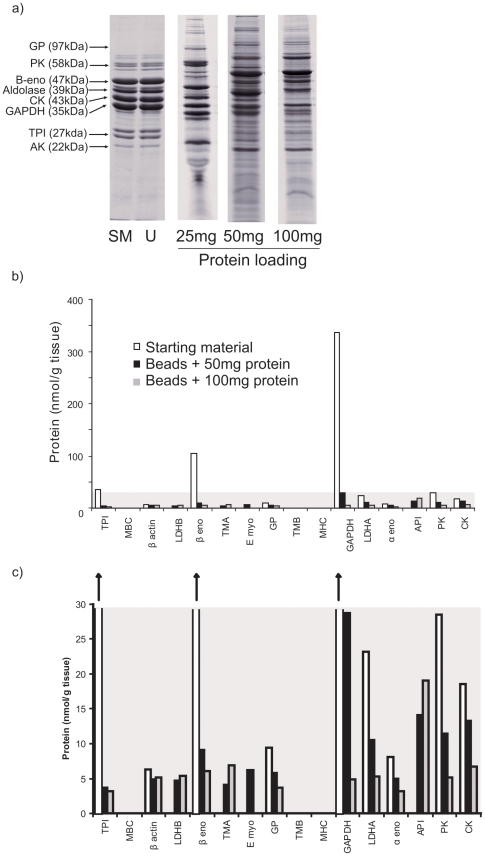
Equalization of skeletal muscle proteins by Prospectrum II equalization.a) Prospectrum II beads (20 mg) were exposed to increasing amounts of soluble protein from chick skeletal muscle (0–100 mg protein loading) in a final volume of 1.0 mL of 20 mM sodium phosphate buffer, pH 7.0. After 2 h, the beads were washed exhaustively (8 successive washes in the same buffer). The beads were recovered, suspended in SDS-PAGE sample buffer and applied directly to a 12.5% (w/v) acrylamide gel along with starting material (SM) and unbound protein (U; from 50 mg protein loading) washed from the beads, prior to staining with Coomassie blue. Individual slices from the gels were analyzed by LC-MS/MS (Table S1). b) To a 10-fold dilution of the bead suspension (diluents 50 mM ammonium bicarbonate) a QconCAT (36 pmol) designed for quantification of chicken skeletal muscle proteins was added, and the entire suspension plus QconCAT was digested to completion with trypsin (protein∶ protease ratio, 20∶1). Resultant peptides were analyzed by LC-MS and the bound proteins were quantified by extraction of the relevant ion chromatograms for the analyte or QconCAT standard peptides. Data are expressed relative to the protein abundance in the original tissue sample and data are included for the un-equalized starting material. c) The lowest panel is an expanded magnification of the shaded area in the b), to emphasize the equalization of lower abundance proteins. Abbreviations: TPI: triosephosphate isomerase; LDHB: lactate dehydrogenase isoform B; β-eno: beta enolase; TMA: tropomyosin A; GP: glycogen phosphorylase; TMB: tropomyosin B; MHC: myosin heavy chain; GAPDH: glyceraldehyde-3-phospate dehydrogenase; LDHA: lactate dehydrogenase isoform A, α-eno: alpha enolase, API: actin polymerization inhibitor, PK: pyruvate kinase; CK: creatine kinase.